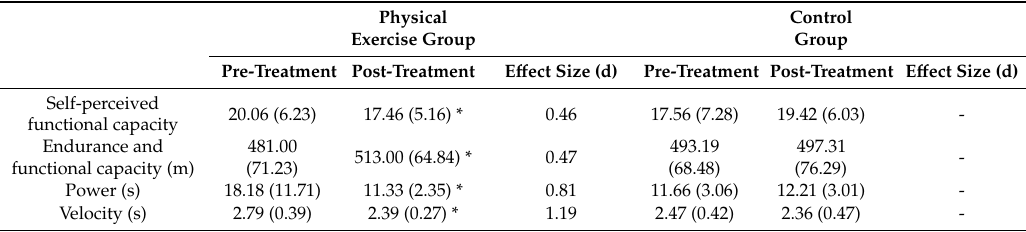
Table 3. E ff ect of the intervention on participants’ physical conditioning. Physical Exercise